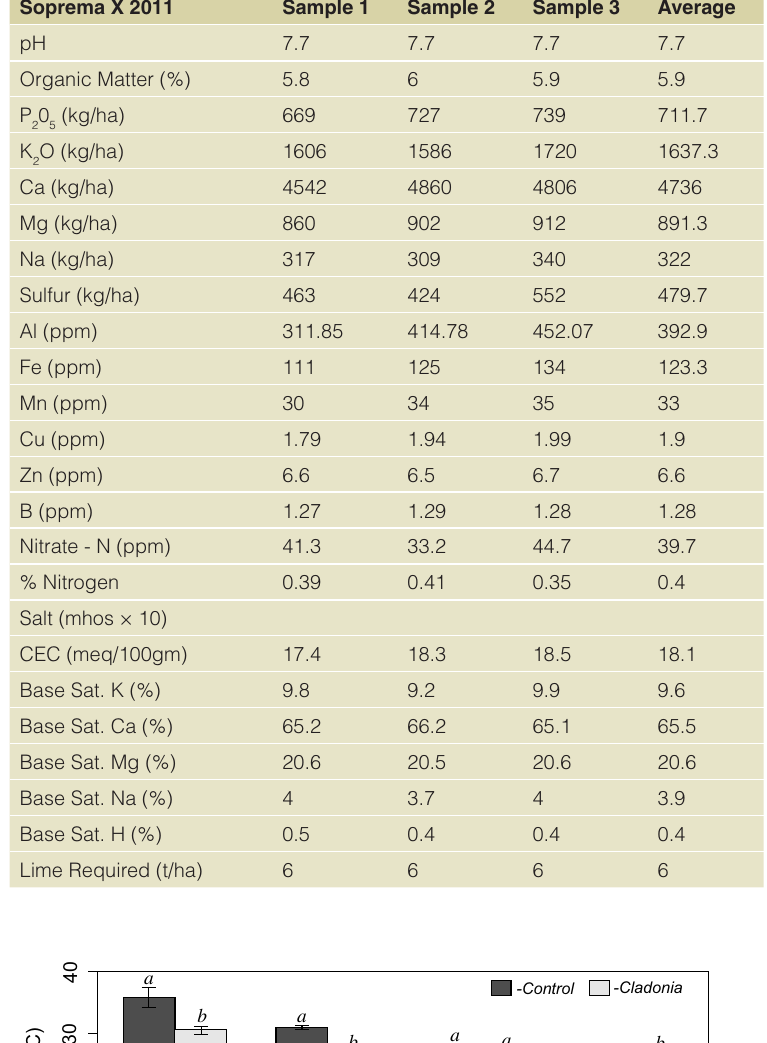
Supplementary Table 1. A soil test conducted by Nova Scotia Agriculture describing the elements present in the Soprema X 2011 substrate.